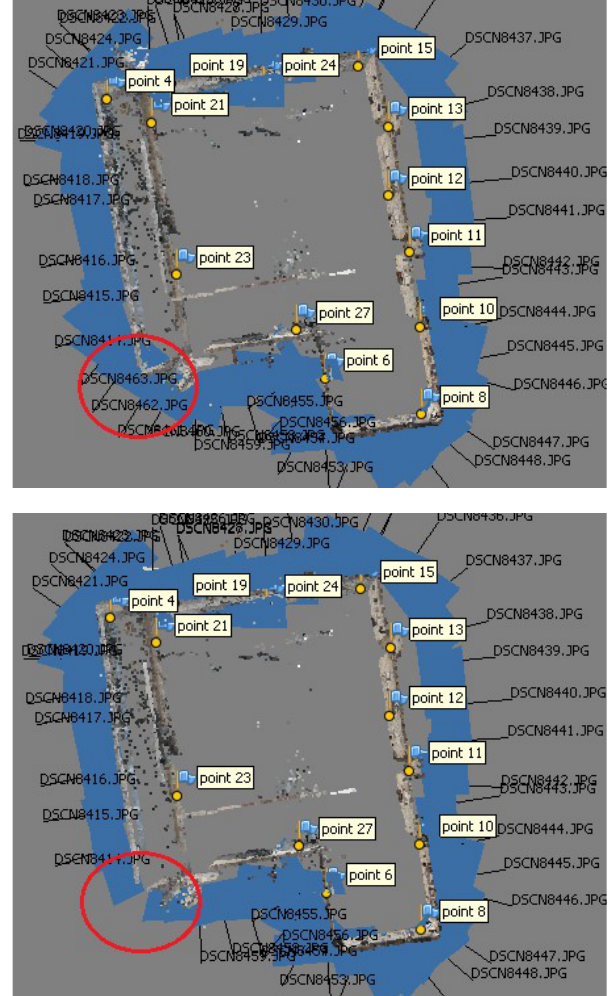
Fig. 2. Loop close (top) and without loop close (bottom)